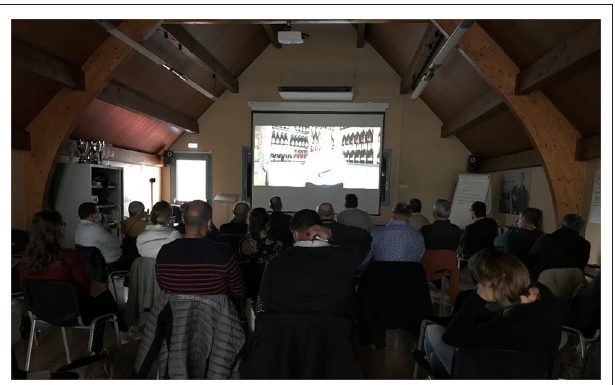
FIGURE 5 | Setting during the viewing of films in the